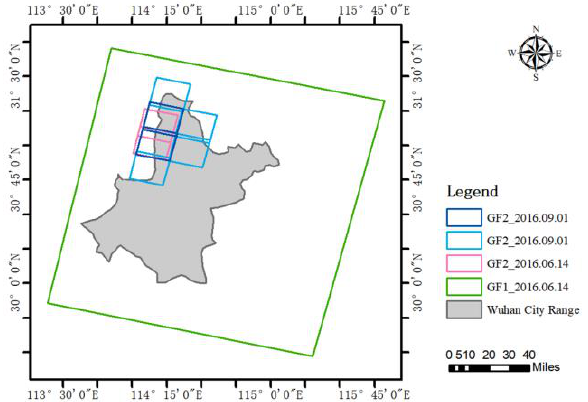
Figure 2 . GF-1 and GF-2 data coverage maps used in the study.